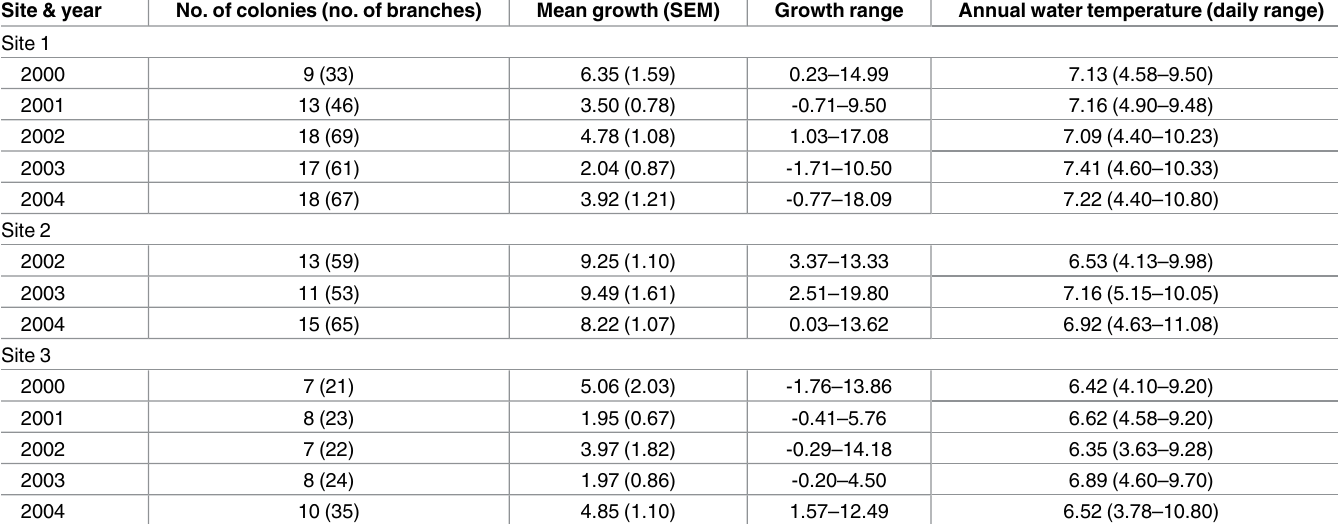
Table 1. Number of Calcigorgia spiculifera colonies (and total branches) for which growth measurements (mm) were made during each year at the three study sites. Growth per colony was calculatedas the averagegrowth of individualbranches. SEM is standard error of the mean. Annualwater temper- ature was recordedas the averageof all daily temperature measurements at each